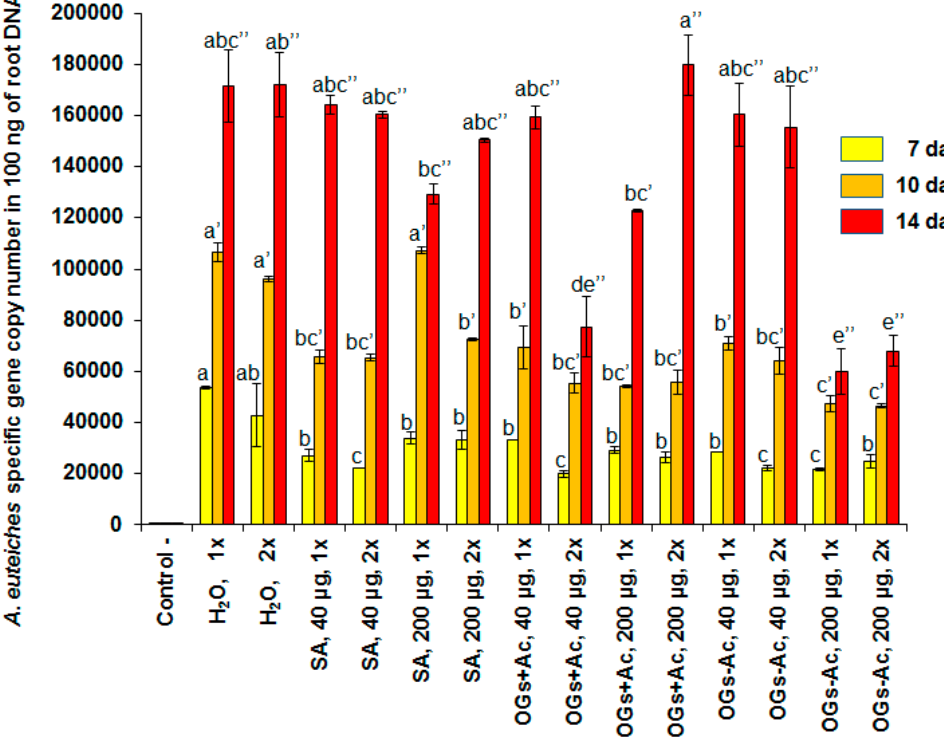
Figure 5. Aphanomyces euteiches specific gene copy numbers in 100 ng of the total DNA extracted from root samples collected at 7, 10 and 14 dai (days after inoculation). Pea plants injected in the upper two rachises with 20 µL/rachis of salicylic acid (SA), acetylated oligogalacturonides (OGs + Ac) or nonacetylated OGs (OGs − Ac). The elicitor injections were done once (1×) two weeks before inoculation (wbi) or twice (2×) two and one wbi. The final elicitor concentrations were 40, 80, 200 or 400 µg/plant. Controls were injected with water. The values shown are means with SD ( n = 5). Different lower-case letters indicate significant differences between treatments according to the Tukey test ( p ≤ 0.05).